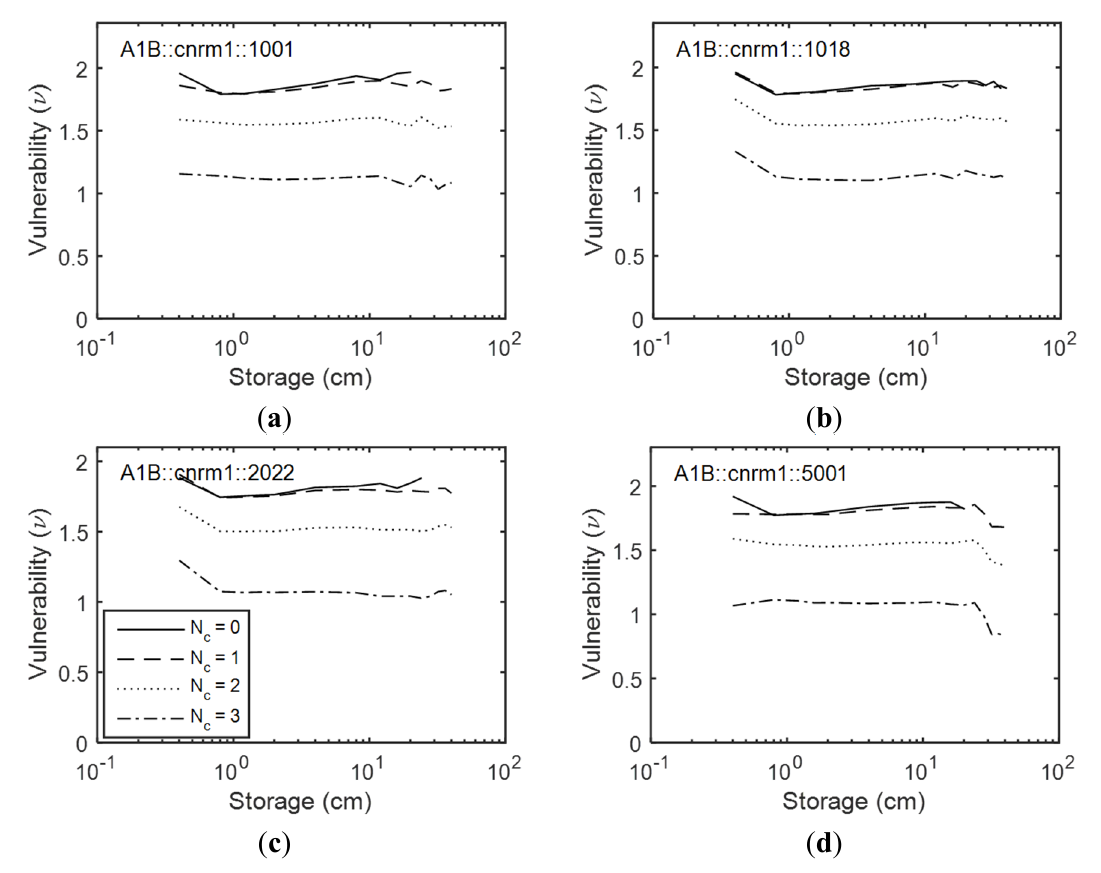
Figure 10. Vulnerabilities of four RBSNs under a projected climate change scenario (A1B, CNRM1) (2070–2099) for the test catchments ( a ) 1001; ( b ) 1018; ( c ) 2022 and ( d ) 5001.